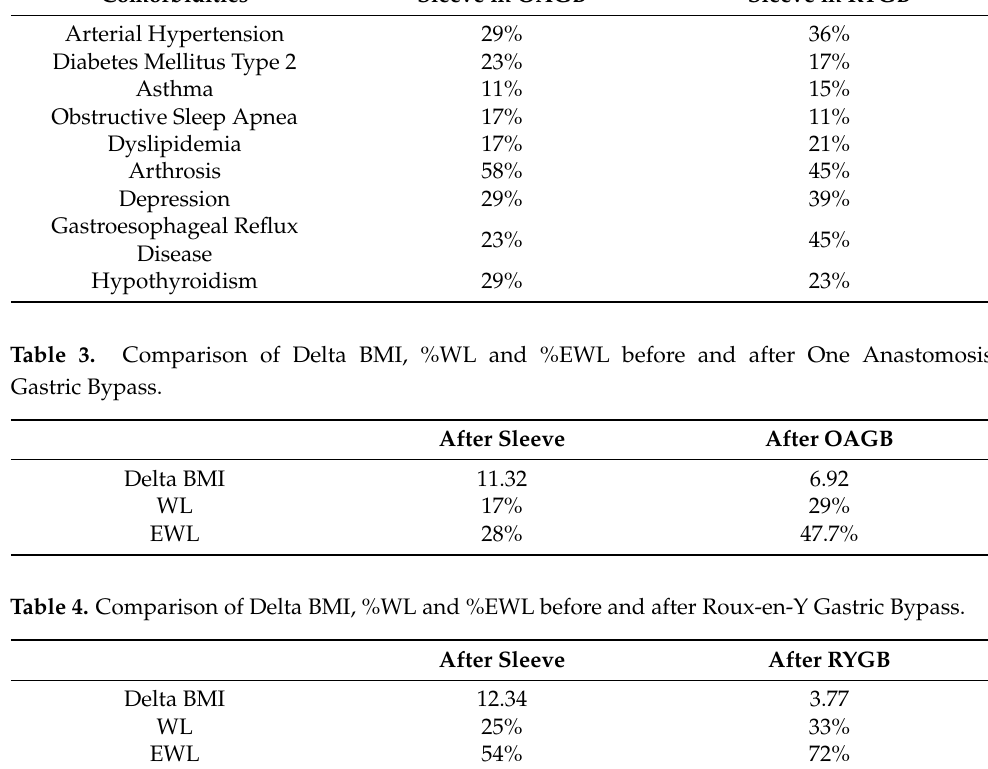
Figure 1. Weight loss after procedures. Table 2. Percentage of comorbidities in the two examined groups. Comorbidities Sleeve in OAGB